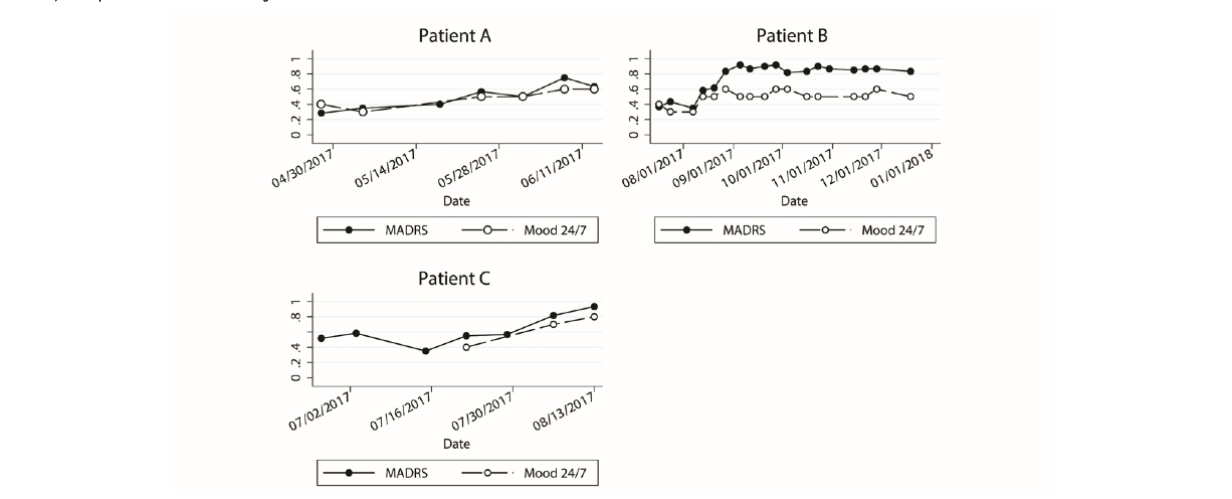
Figure 4. Scaled Mood 24/7 and Montgomery-Åsberg Depression Rating Scale (MADRS) scores over 3 months. A mixed effects model analysis was applied to the longitudinal data shown here. Scaled MADRS and Mood 24/7 ratings are shown by the patient. Data points represent clinician or patient mood scores for that given day. Mixed model analysis indicates significant concordance between Mood 24/7 and MADRS scores within each patient ( P <.001), and postestimation analysis showed an intraclass correlation of